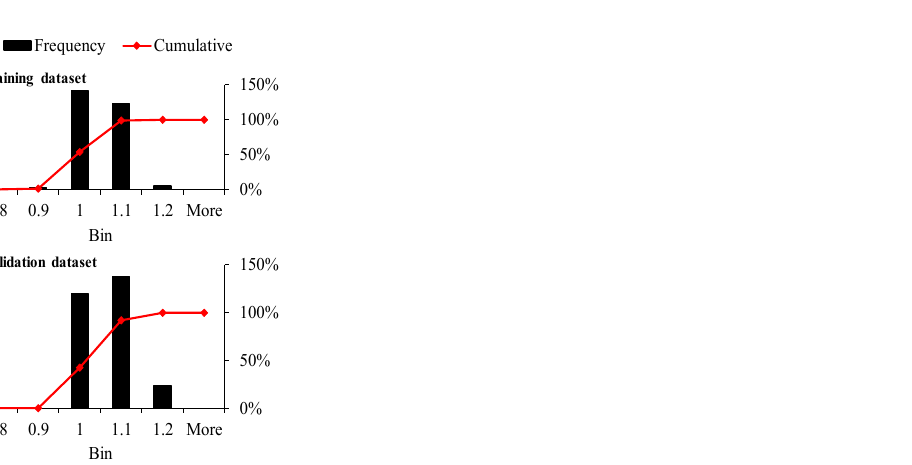
within 0.9 to 1.1 for the training and validation datasets, respectively. This manifests the model error within ±10%, reflecting a more robust performance for the selected optimum model.